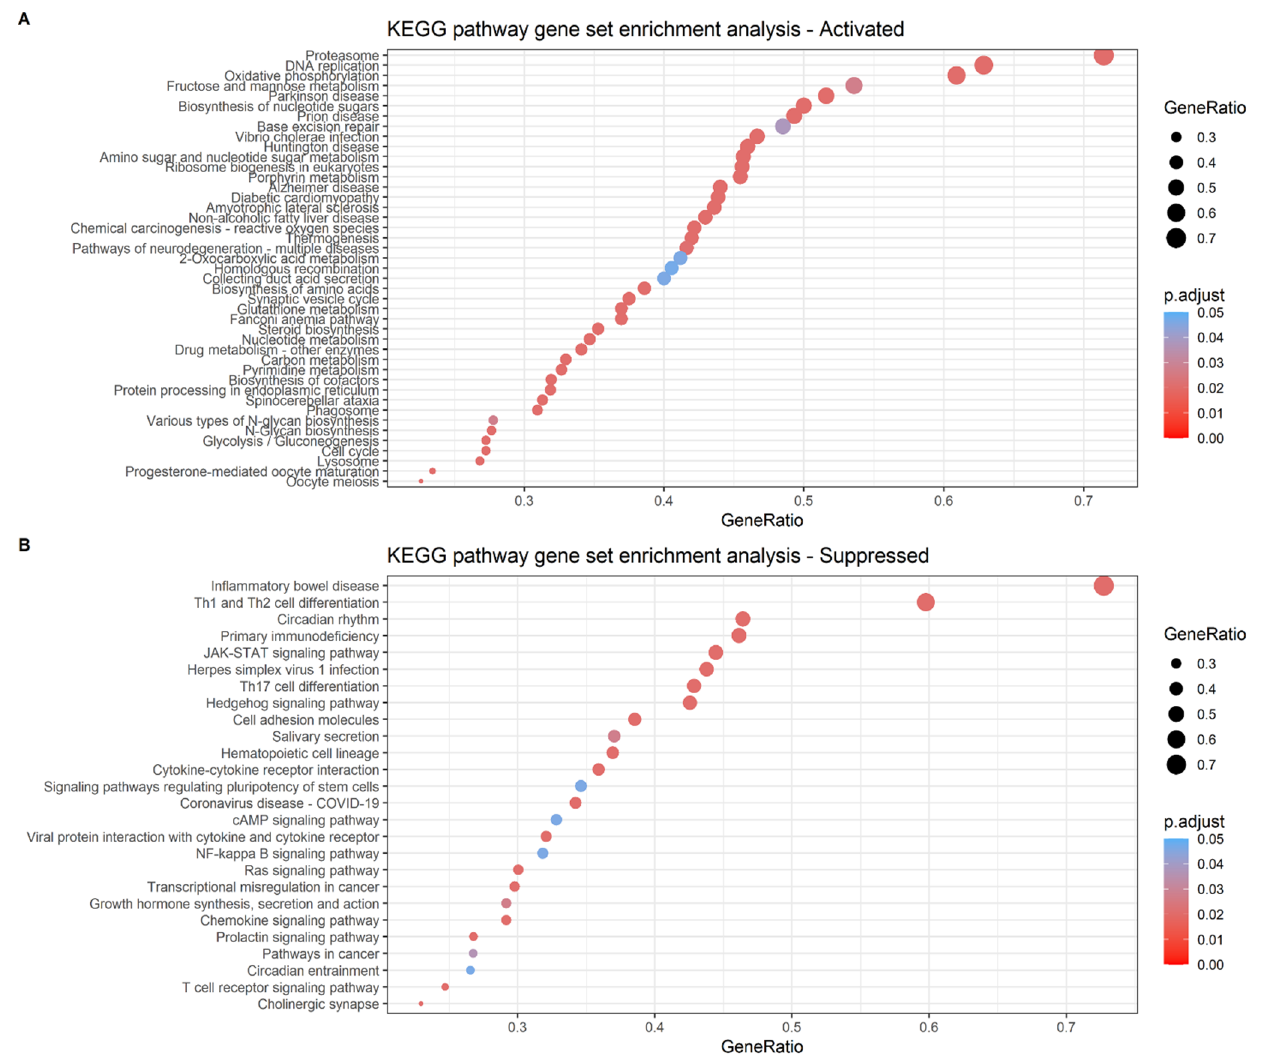
Figure 10. KEGG pathway gene set enrichment analysis for the ranked genes. Size of dots represents the GeneRatio while the color represents the p value. ( A ) Proteosome, DNA replication, oxidative phosphorylation and base excision repair pathways were significantly activated in the high-risk group as compared to the low-risk group. ( B ) Immunity pathways such as Th1 and Th2 cell differentiation, JAK-STAT signaling pathway and Th17 cell differentiation were suppressed in the high-risk group as compared to the low-risk group.